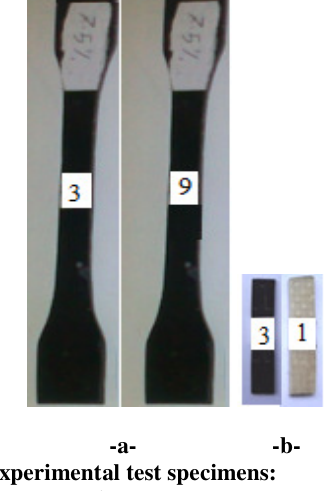
Fig. 1. Experimental test specimens: a- Tensile test specimens. b- Charpy impact test specimens.